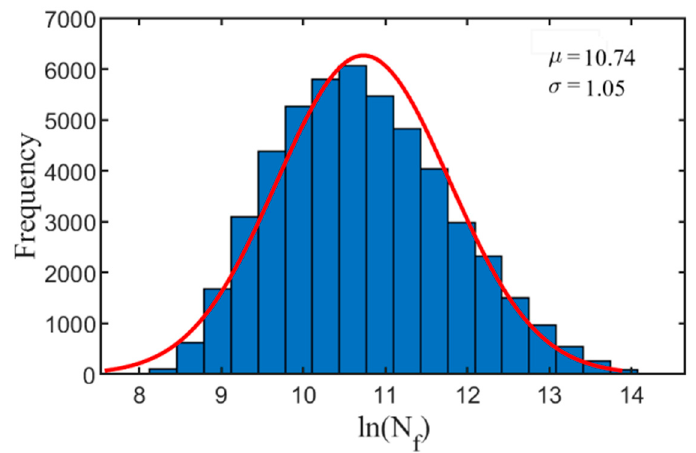
Figure 10. Frequency distribution of predicted